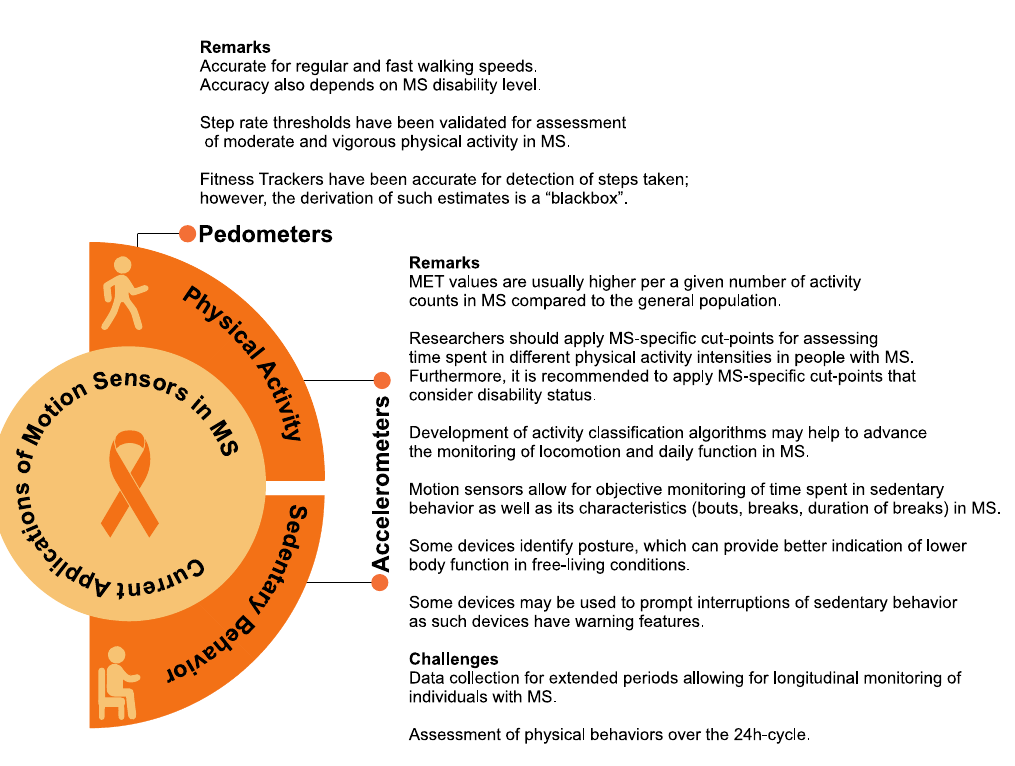
Figure 2. Summary of the evidence on the use of accelerometers and pedometers in Figure 2 . Summary of the evidence on the use of accelerometers and pedometers in MS .